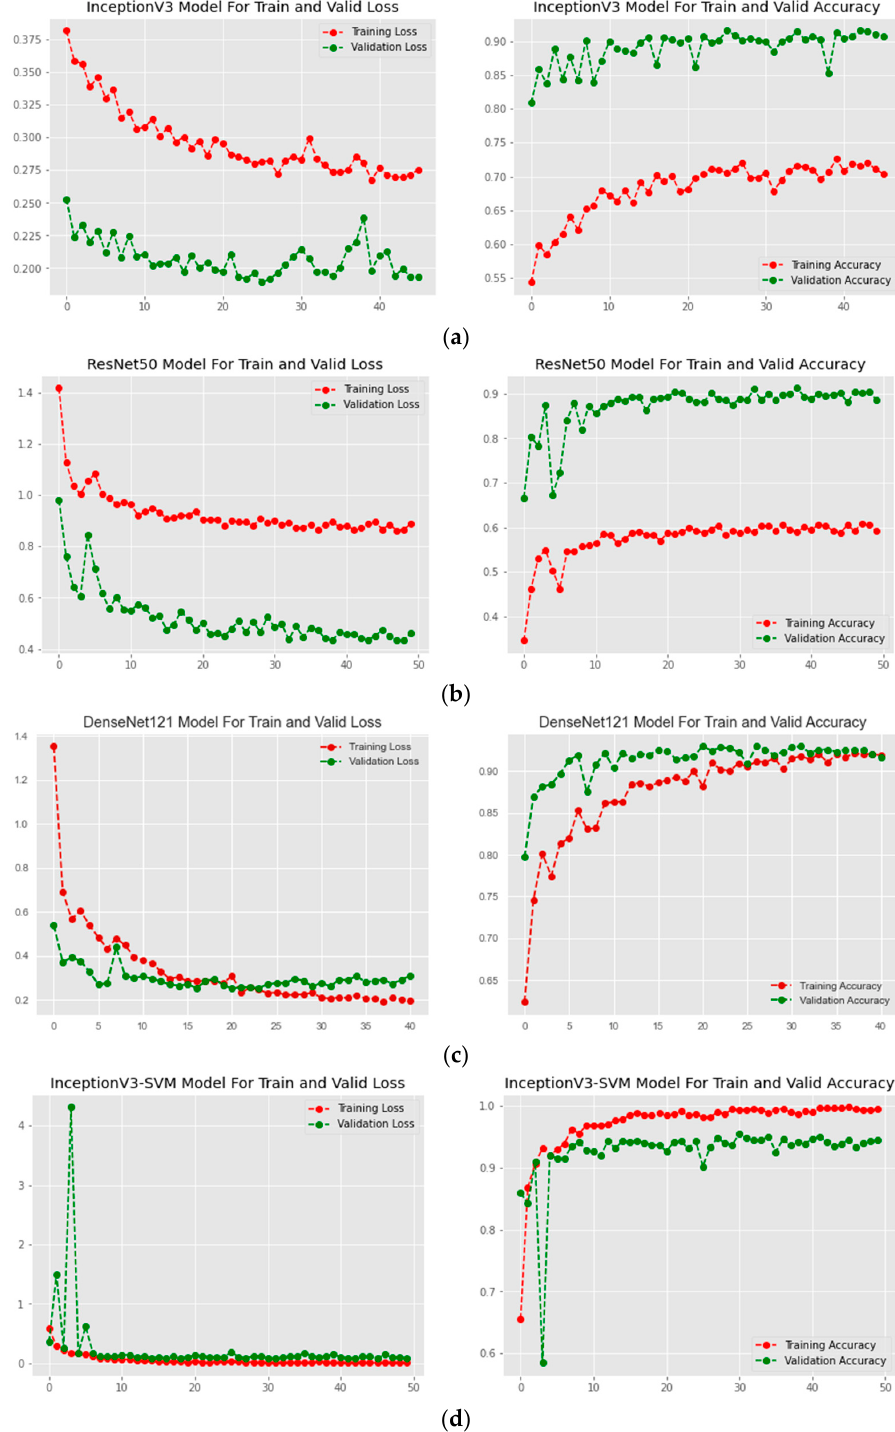
Figure 2. Accuracy and loss graphs of DCNN models: ( a ) InceptionV3; ( b ) ResNet50; ( c ) DenseNet121; and ( d ) Proposed Inception-SVM.